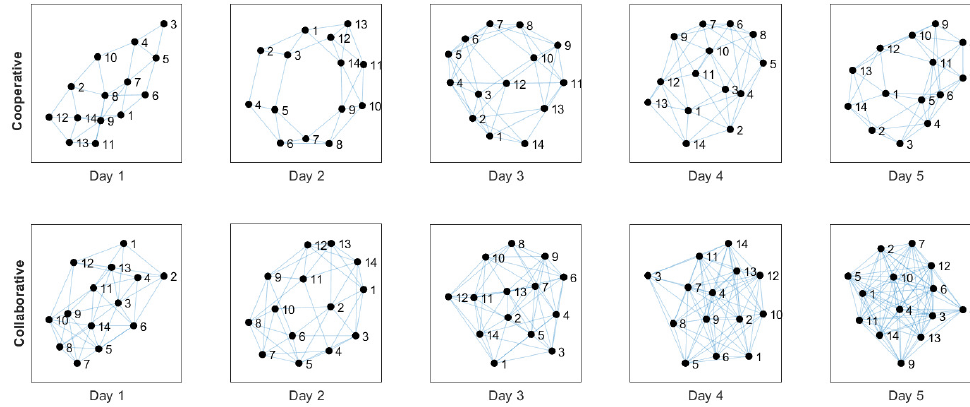
Figure 3. Logical change of topology through 5 days under each system